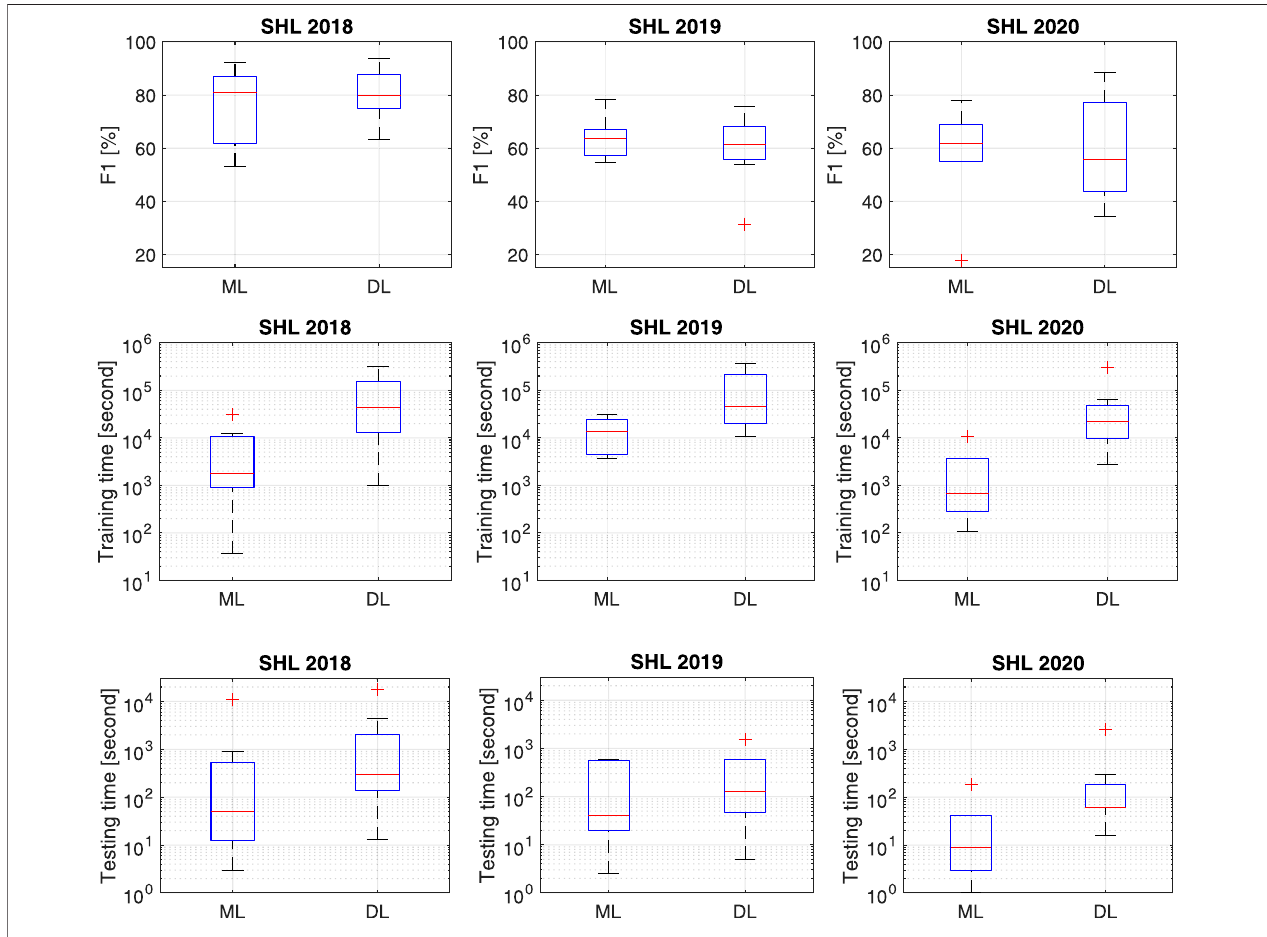
FIGURE 11 | Comparison between classical machine learning and deep learning approaches. (A) F1 score for the testing data. (B) Training time. (C) Testing time. The boxplot illustrates the minimum, fi rst quartile, median, third quartile, and maximum values in each group of data, and the also the outlier values.